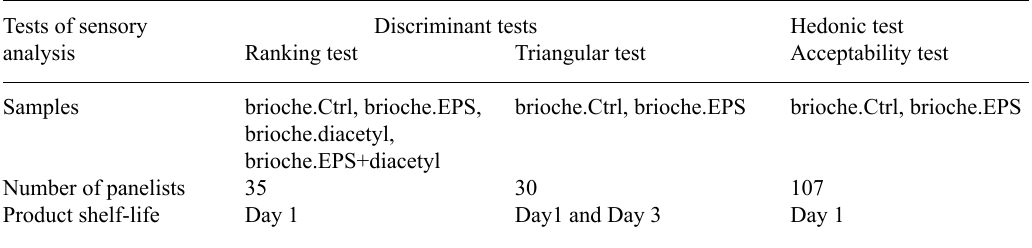
table 2. Details of the four sensory analysis tests